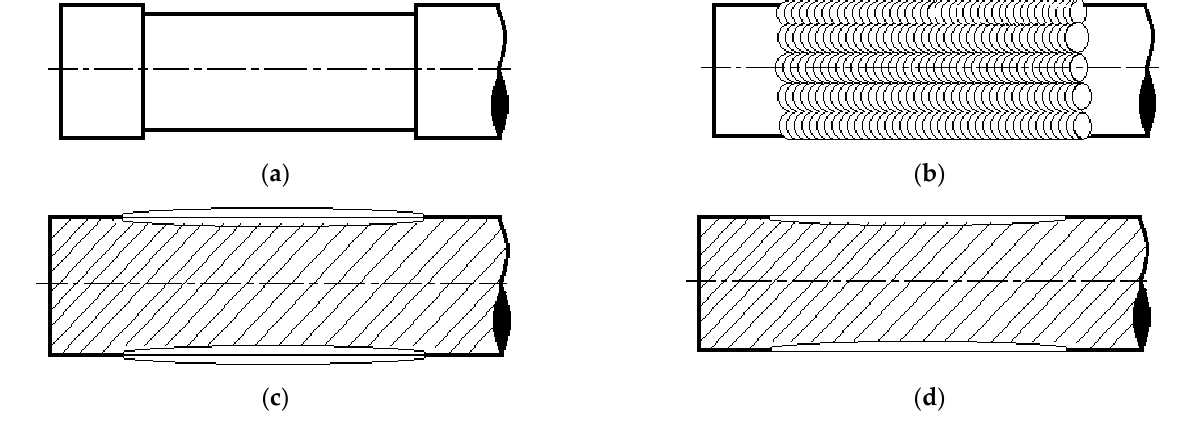
Figure 5. Course of rebuilding by hardfacing of shaft journals. Sandblasted surface of used shaft ( a ), bead pattern after coating ( b , c ), shaft after finish grinding ( d ) (diagram).